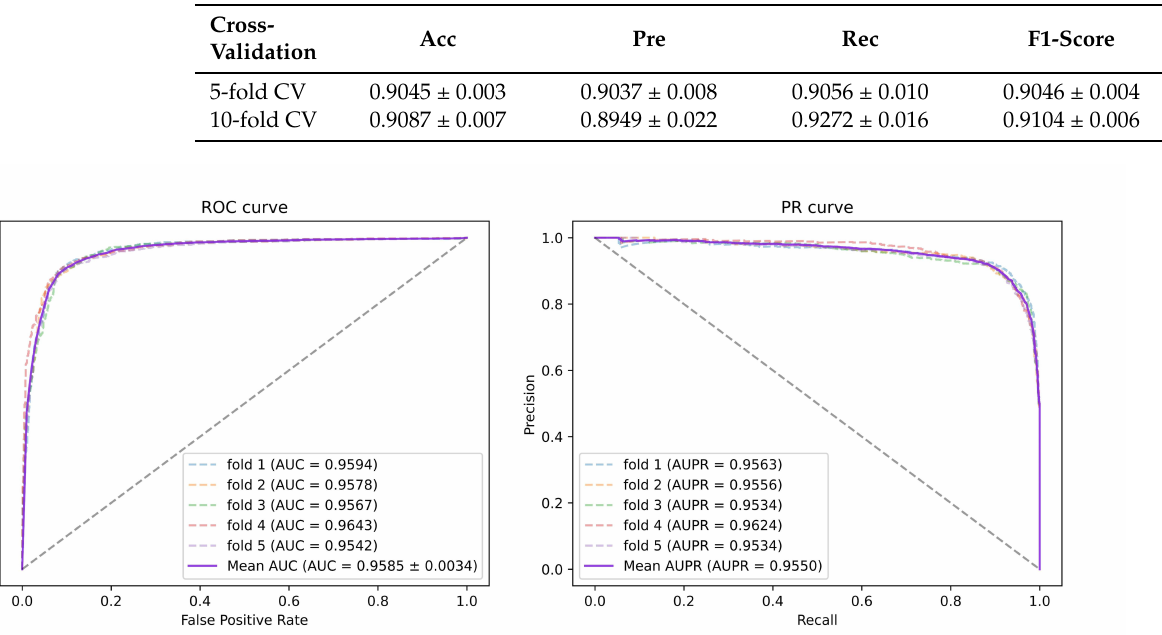
Figure 2. The 5-fold cross-validated ROC curve and PR curve of SGAEMDA model with AUC of 95.85% and AUPR of